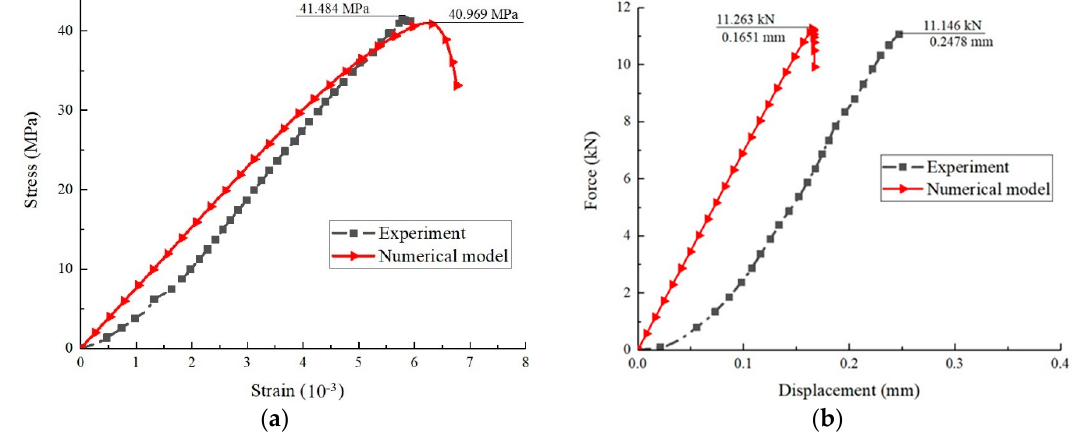
Figur e 11 . Test results: ( a ) stress–strain curve for unconfined compression test; ( b ) force–displacement curve for splitting test.